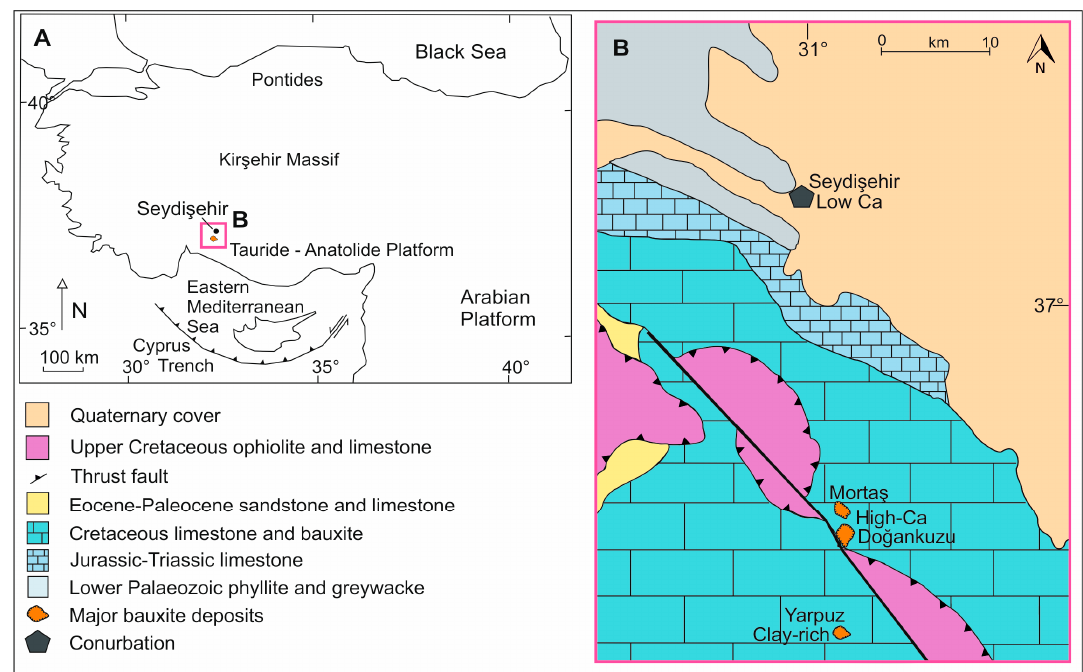
Figure 1. ( A ) Location of bauxite samples and ( B ) the regional geological setting. Adapted after [9].